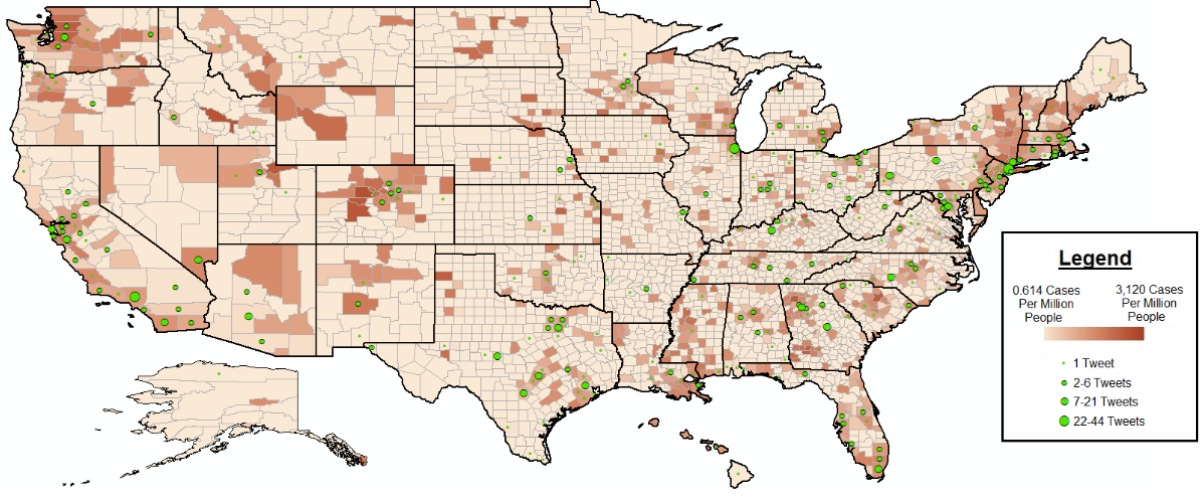
Figure 3. Distribution of tweets originating from the United States as point coordinates overlaid on a choropleth gradient denoting population-normalized coronavirus disease cases on March 20, 2020 (final day of data